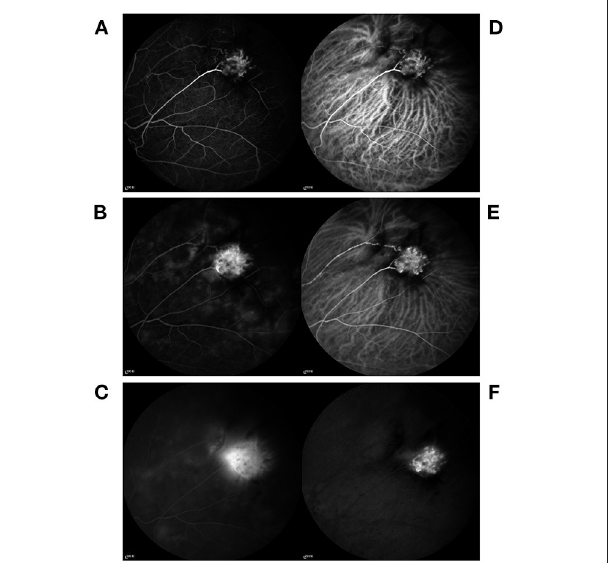
FIGURE 3 | Fluorescein and indocyanine green angiography imaging in the left eye. (A–C) Fluorescein angiography showed the hyperfluorescence of the left eye mass to be at an early stage and the leakage to be at a late stage. (D–F) Indocyanine green angiography revealed the hypercyanescence to be at the middle and late